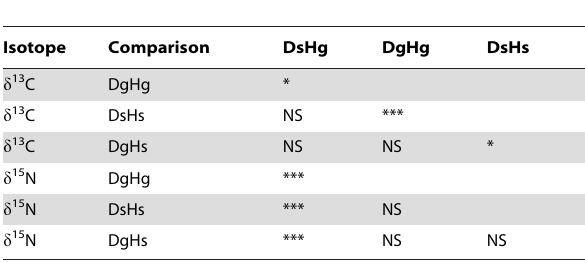
Table 4. Tukey’s post hoc results comparing variances between models using the four common prey species (Part 1) for d 13 C and d 15